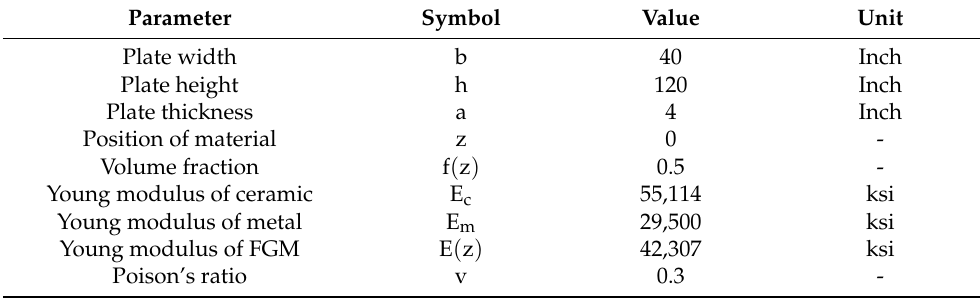
Table 1. Input Parameters for the model